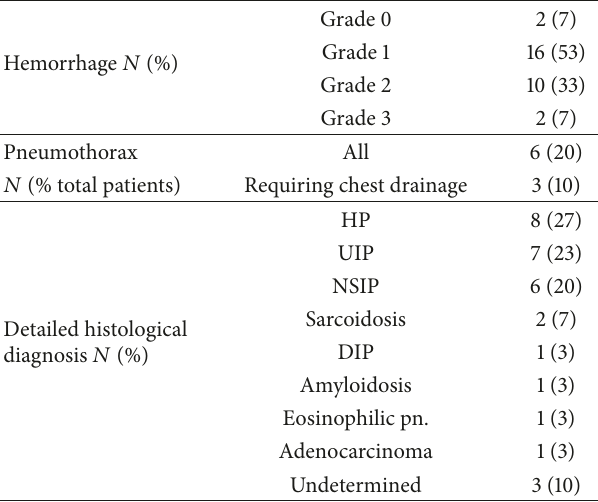
Table 2: Complications and histological diagnosis of the TBLCs ( 𝑁 = 30